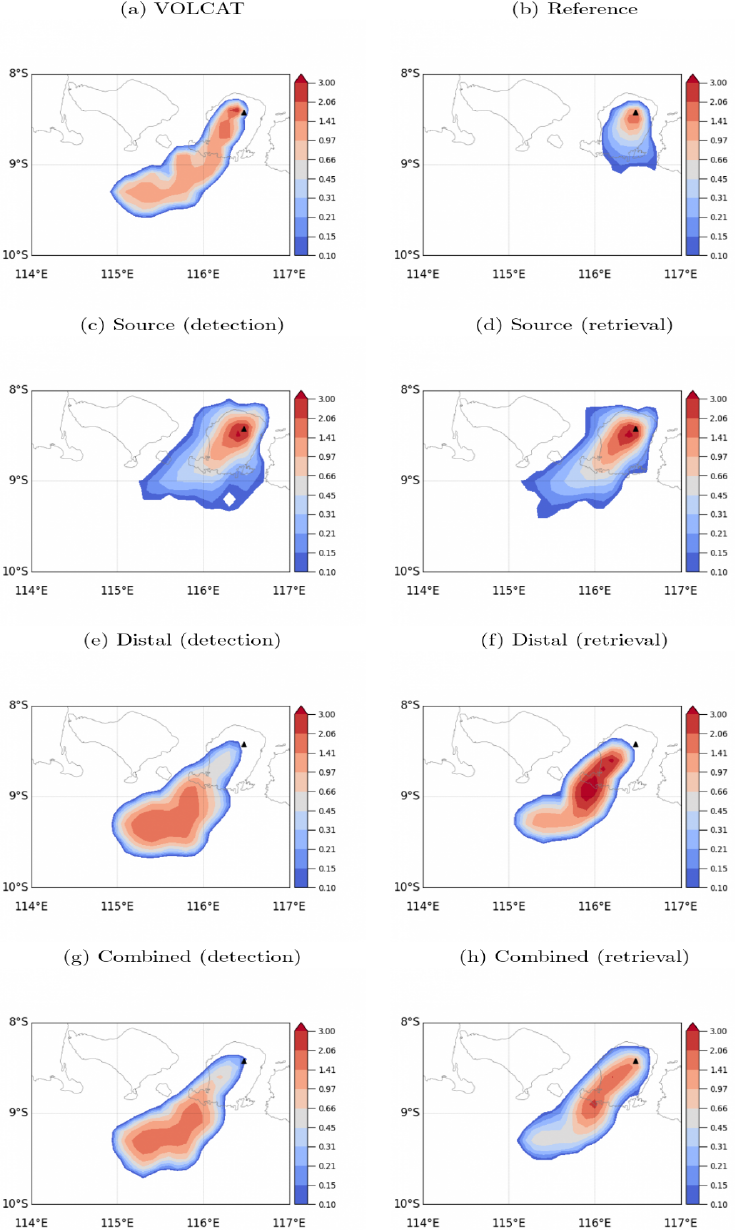
Figure 7. Mass load fields (in g/m 2 ) in the 4 November 2015 Rinjani eruption case study at 5/0730 UTC for ( a ) VOLCAT retrieval, ( b ) reference run, ( c ) cylindrical source run with detection-based optimization, ( d ) cylindrical source run with retrieval-based optimizations, ( e ) distal source run with detection-based initialization and optimization, ( f ) distal source run with retrieval-based initialization and optimization, ( g ) hybrid source run using detections, and ( g ) hybrid source run using retrievals. The mass loads in ( b – h ) are ensemble means.